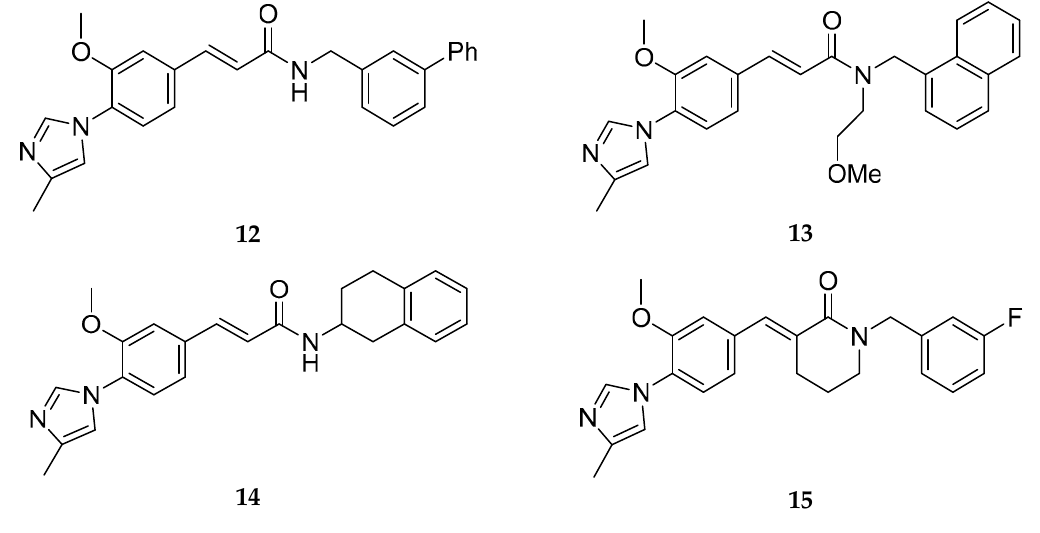
Figure 13. Examples of Eisai cinnamides.